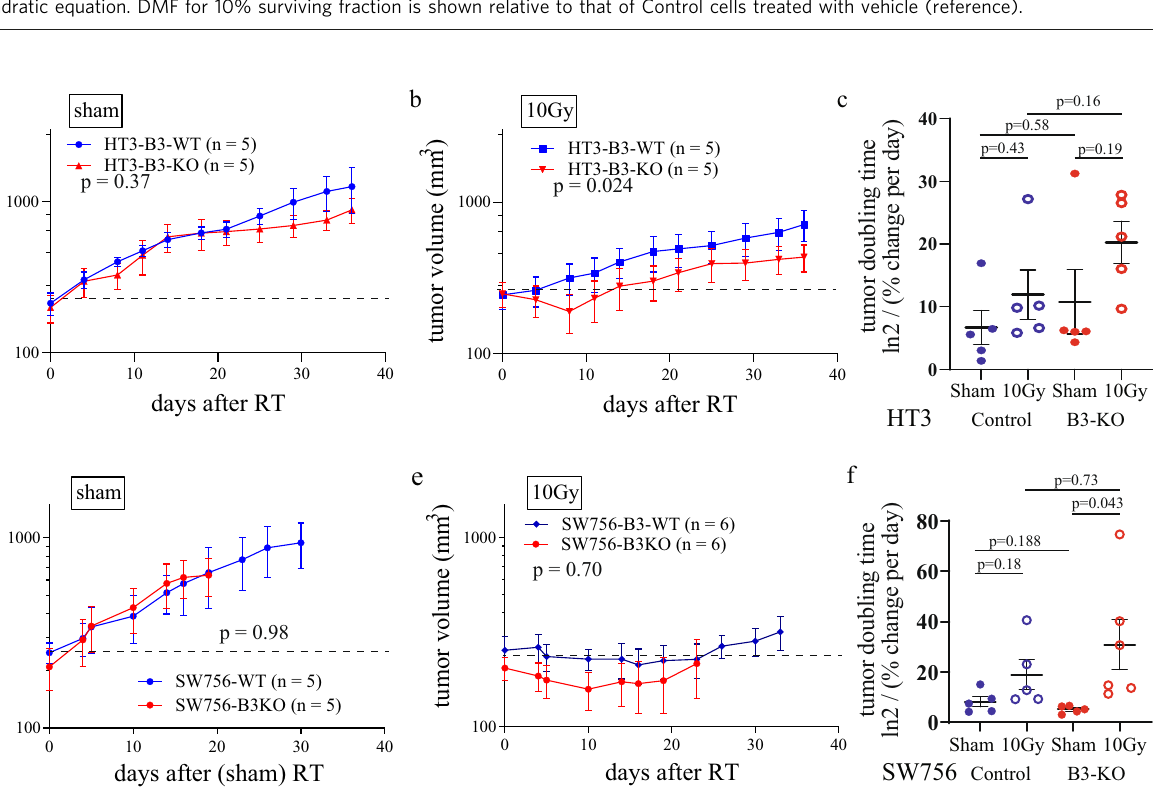
Fig. 1 SERPINB3-KO cells are more sensitive to radiation and cisplatin-induced cell death. a , b Western blot showing SERPINB3 in B3-WT and B3-KO cell lines. Percent Sytox-positive CRISPR-Control (B3-WT) and SERPINB3-KO (B3-KO) cells at indicated time points after 2, 10, or 30 Gy RT in SW756 ( a ) and 2, 4, or 10 Gy in HT3 ( b ). P -value displays sample variation for two-way ANOVA with replicates over time, n.s. not signi fi cant (bar = mean of triplicate wells, 2 – 4 fi elds of view per well, error bars = standard deviations, one representative of three biologic replicates shown). c Representative confocal fl uorescent images of SW756- and HT3-B3-WT and -B3-KO Sytox (pseudo-colored green) and merge of Hoescht (pseudo-colored blue) and Sytox images at 84 h post-treatment. Scale bar indicates 50 µ m. d , e Percent Sytox-positive cells following treatment with increasing doses of RT with or without cisplatin at 96 h in SW756 ( d ) and HT3 ( e ) background (bar = mean of triplicate wells, 2 – 4 fi elds of view per well, error bars = standard deviations, one